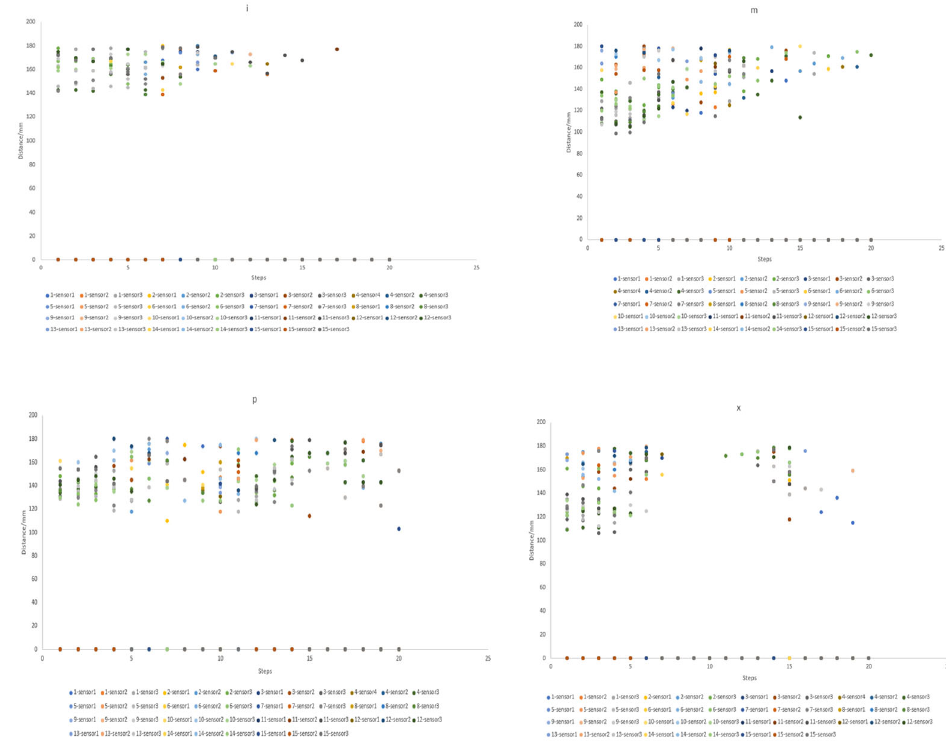
Figure 4. The signals of “i”, “m”, “p” and “x” from three ToF sensors.